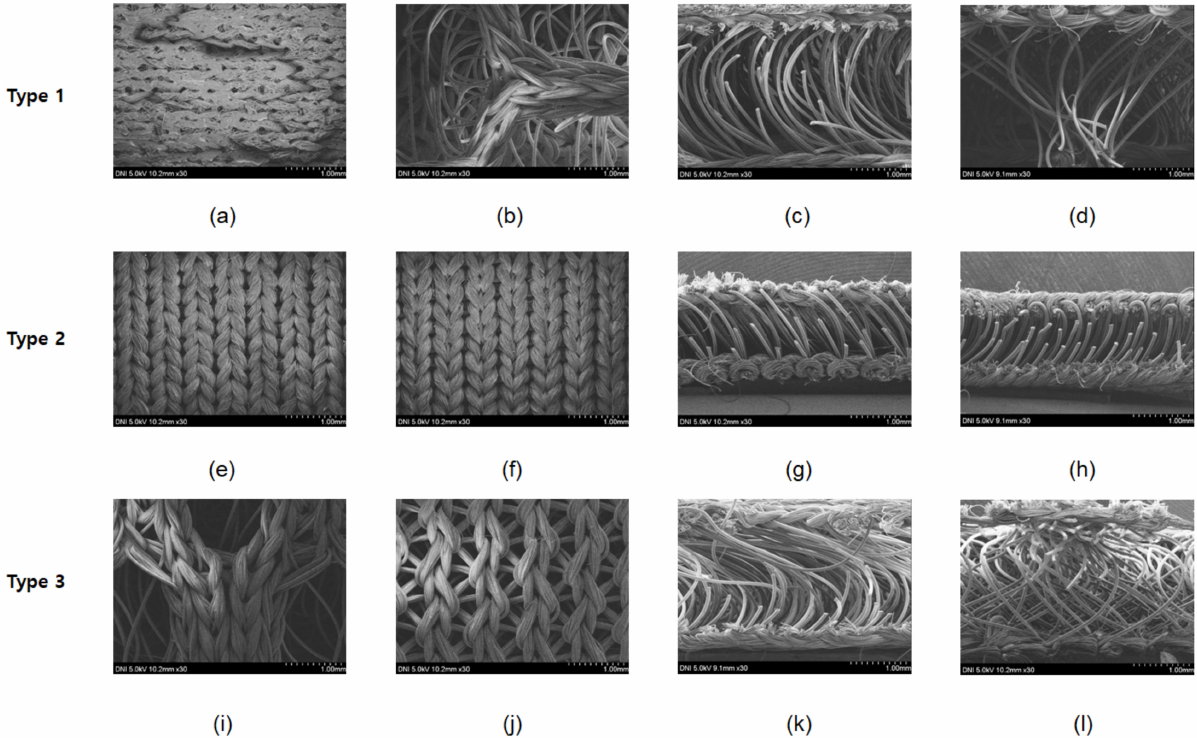
Figure 3. ( a ) The front surface of Type 1 fabric. ( b ) The back surface of Type 1 fabric; ( c ) The (100) cross section of Type 1 fabric; ( d ) The (010) cross section of Type 1 fabric; ( e ) The front surface of Type 2 fabric; ( f ) The back surface of Type 2 fabric; ( g ) The (100) cross section of Type 2 fabric; ( h ) The (010) cross section of Type 2 fabric; ( i ) The front surface of Type 3 fabric; ( j ) The back surface of Type 3 fabric; ( k ) The (100) cross section of Type 3 fabric; ( l ) The (010) cross section of Type 3